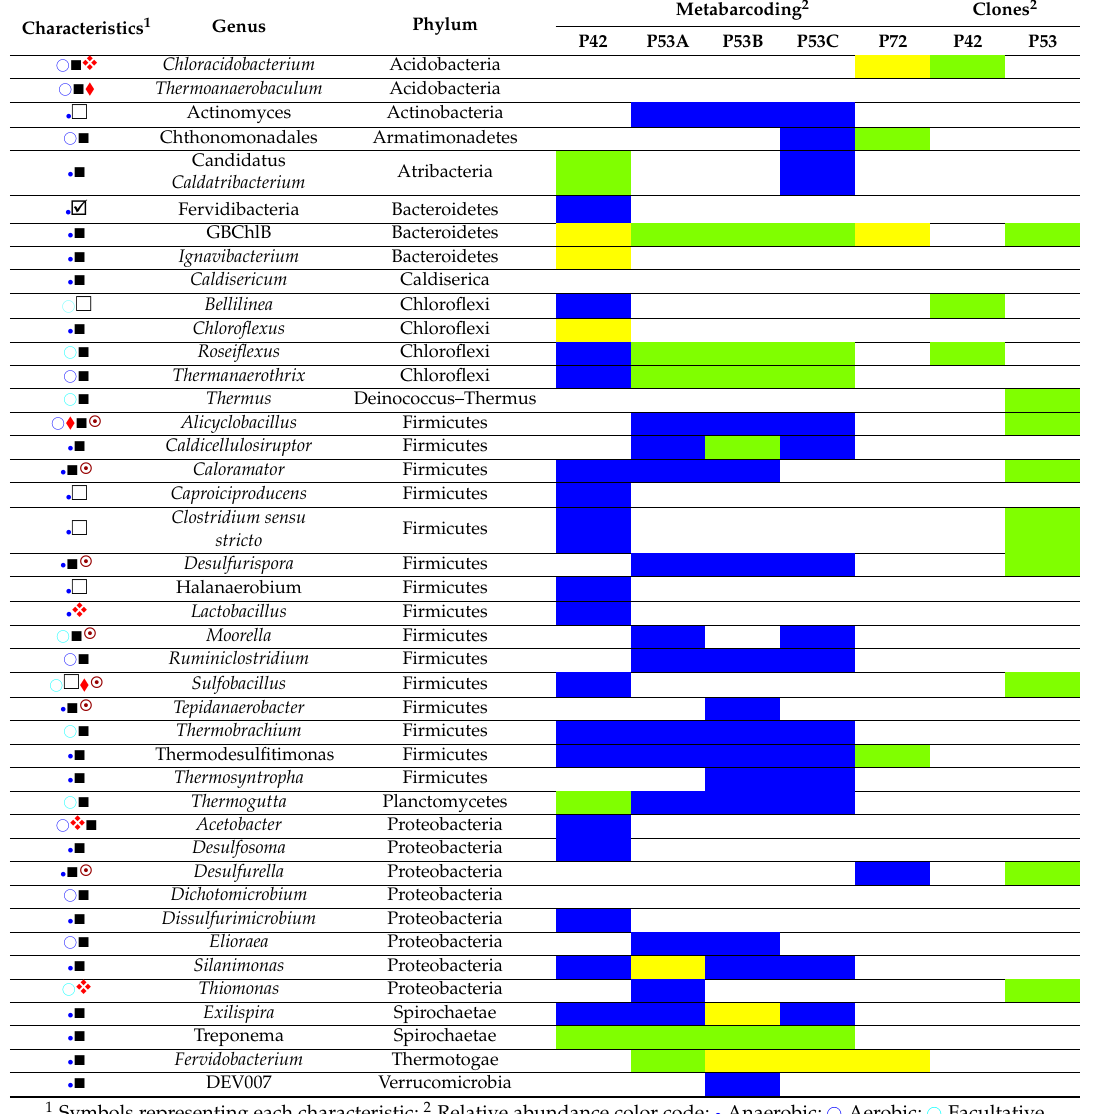
Microorganisms 2020 , 8 , 208 Table 2. Genera described as aerobic, anaerobic thermophilic, thermotolerant, acidophilic and or acidotolerant of the Lirima hot springs. Table 2. Genera described as aerobic, anaerobic thermophilic, thermotolerant, acidophilic and or acidotolerant of the Lirima hot springs. Table 2. Genera described as aerobic, anaerobic thermophilic, thermotolerant, acidophilic and or Metabarcoding 2 acidotolerant of the Lirima hot springs. Table 2. Genera described as aerobic, anaerobic thermophilic, thermotolerant, acidophilic and or Characteristics 1 Genus Phylum acidotolerant of the Lirima hot springs. Table 2. Genera described as aerobic, anaerobic thermophilic, thermotolerant, acidophilic and or acidotolerant of the Lirima hot springs. Table 2. Genera described as aerobic, anaerobic thermophilic, thermotolerant, acidophilic and or acidotolerant of the Lirima hot springs.